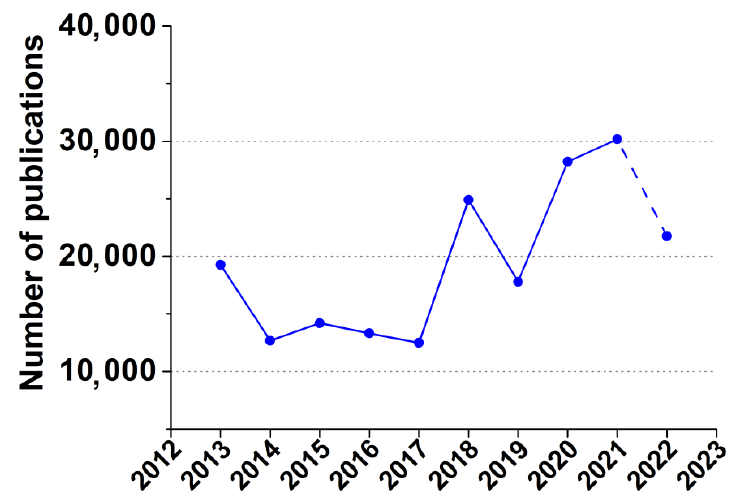
Figure 2. Number of publications on molecular dynamic simulations in drug delivery systems’ design. Data obtained via Dimensions (https://app.dimensions.ai/discover/publication, (accessed on 24 October 2022)) using keywords «molecular dynamic simulations drug delivery systems».